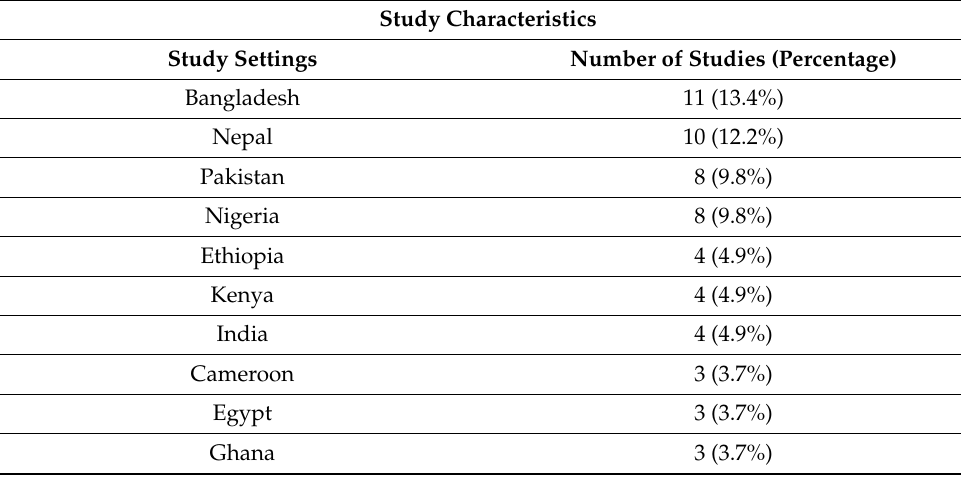
Table 4. Characteristics of included studies in this